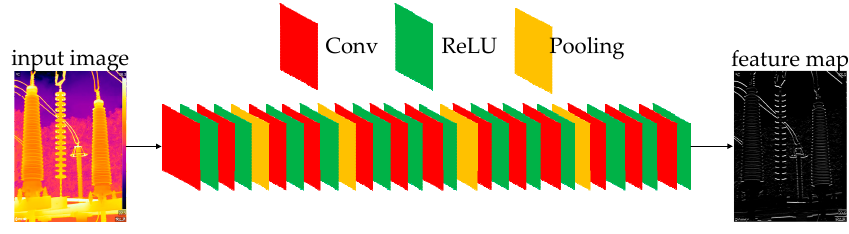
Figure 2. Structure of VGG16 convolutional neural network.